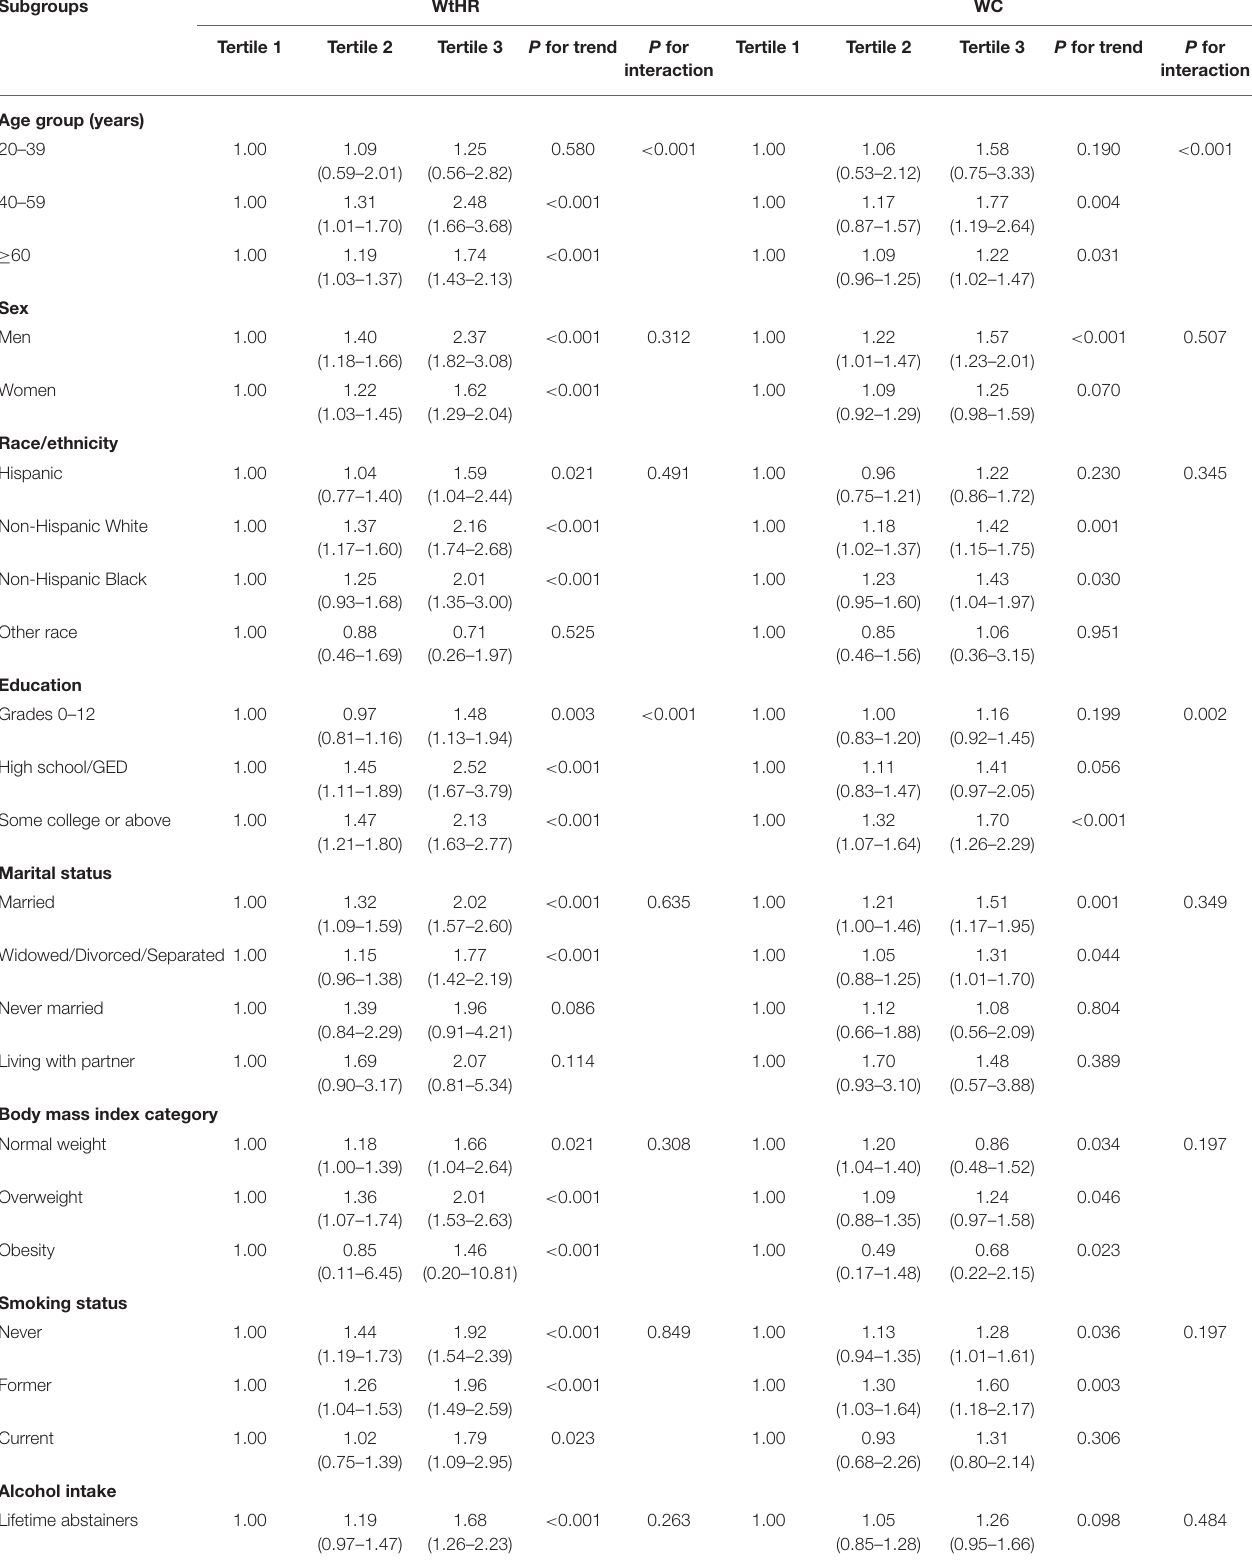
TABLE 4 | Stratified analysis of associations between the WtHR and WC with all-cause mortality. Subgroups WtHR WC Tertile 1 Tertile 2 Tertile 3 P for trend P for Tertile 1 Tertile 2 Tertile 3 P for trend P for interaction